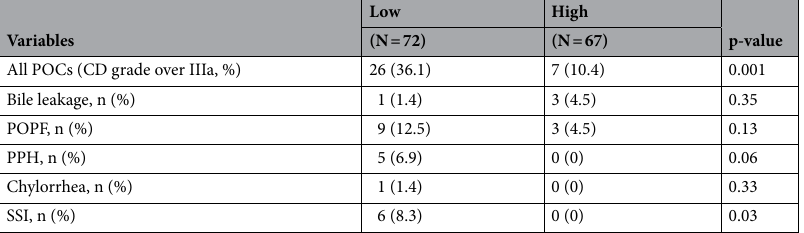
Table 3. Comparison of the frequency of postoperative complications (CD grade ≧ III) between the study groups. POCs, postoperative complications; POPF, postoperative pancreatic fistula; PPH, postpancreatectomy hemorrhage; SSI, surgical site infections; pancreatoduodenectomy; CD, Clavien–Dindo Classification.